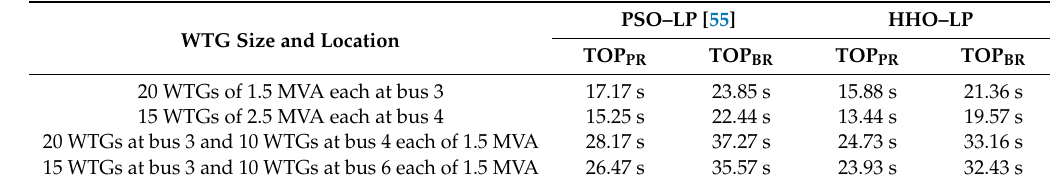
Table 7. Performance improvement in terms of overall operation time of relay obtained using